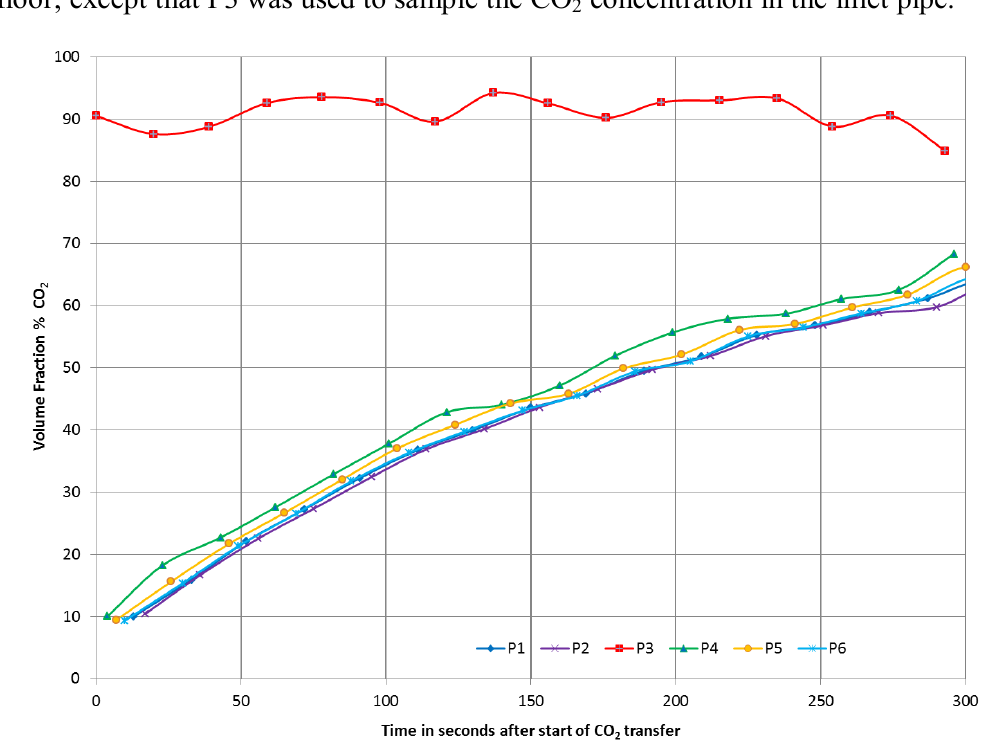
Figure 1. The experimental CO concentration measured in the dumpster mock-up during 2 the 5 min wash-in period. The test points listed in the legend were on a plane 25 cm above the floor, except that P3 was used to sample the CO concentration in the inlet 2